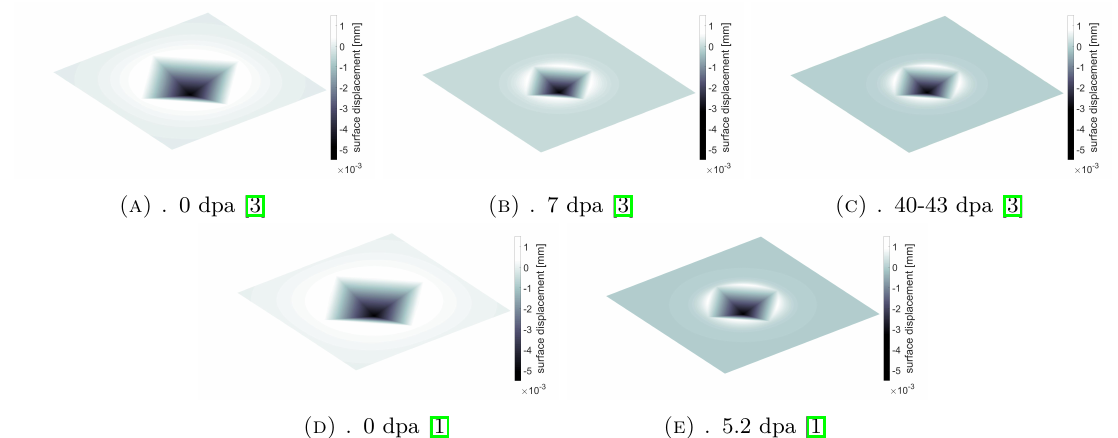
Figure 8. Computed indents; non-irradiated samples A and D, neutron-irradiated samples B, C and E; dataset [3] A, B and C, dataset [1] D and E; depicted surface area 30x30